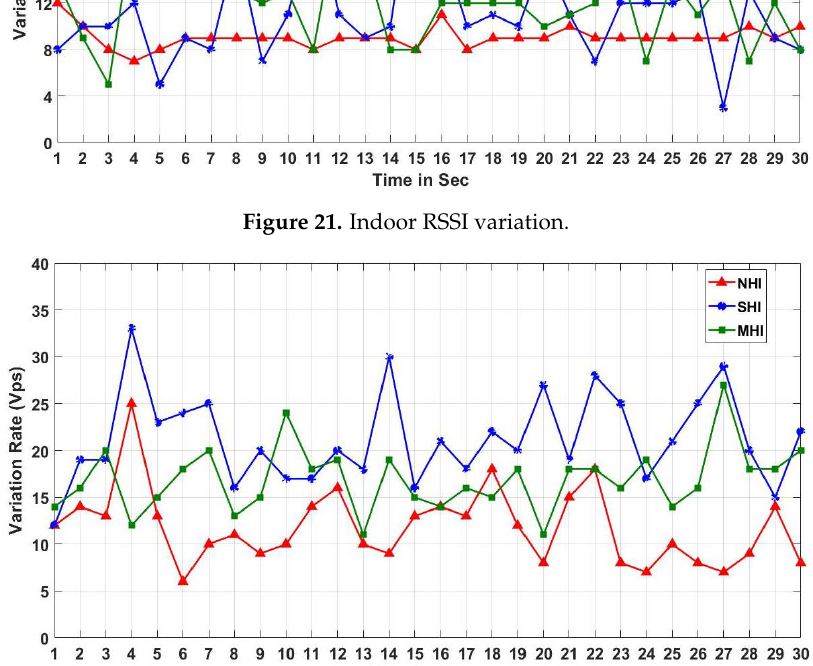
Figure 22. Outdoor RSSI